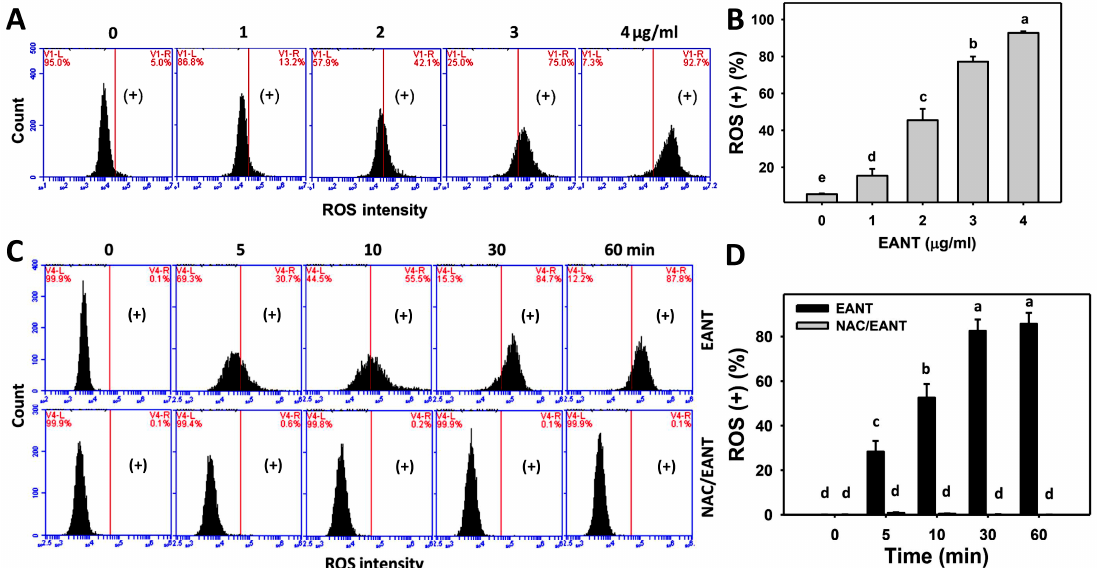
Figure 5. ROS content of EANT-treated leukemia cells. ( A , B ) Histogram and statistical analysis for ROS content. (+) at the right side of each panel is regarded as the population of ROS (+) (%). HL-60 cells were treated with EANT (1 h, 0 to 4 μ g/mL). The control contained 0 μ g/mL EANT but 0.1% DMSO. ( C , D ) Histogram and statistical analysis for ROS content of HL-60 cells following NAC/EANT treatment. NAC/EANT indicates that cells are either pretreated with NAC (5 mM, 1 h) or post-treated with EANT (0 and 4 μ g/mL for 0 to 60 min). Data, mean ± SD ( n = 3). Data showing different alphabets at the top reveal a significant difference ( p < 0.05–0.0001 for multiple comparisons).